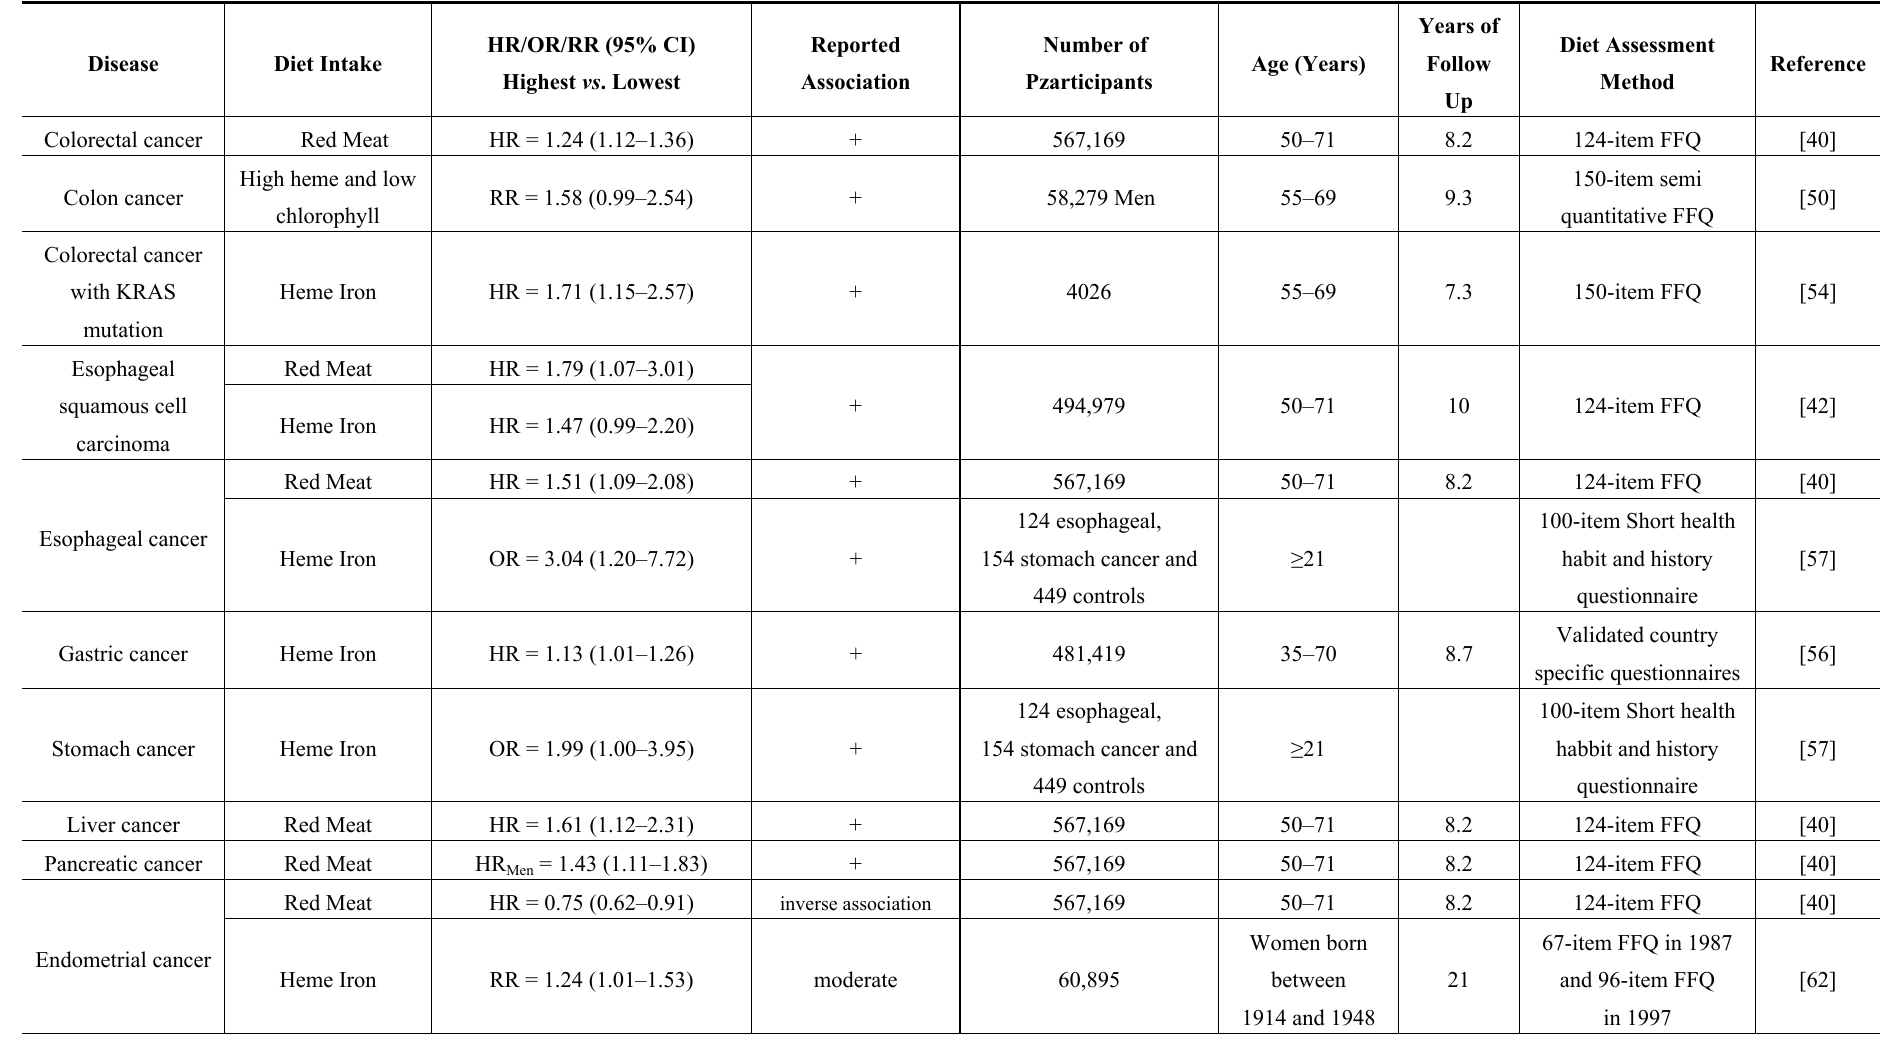
Table 1. Summary of epidemiological studies investigating the association between dietary intake of heme iron and/or red meat with various